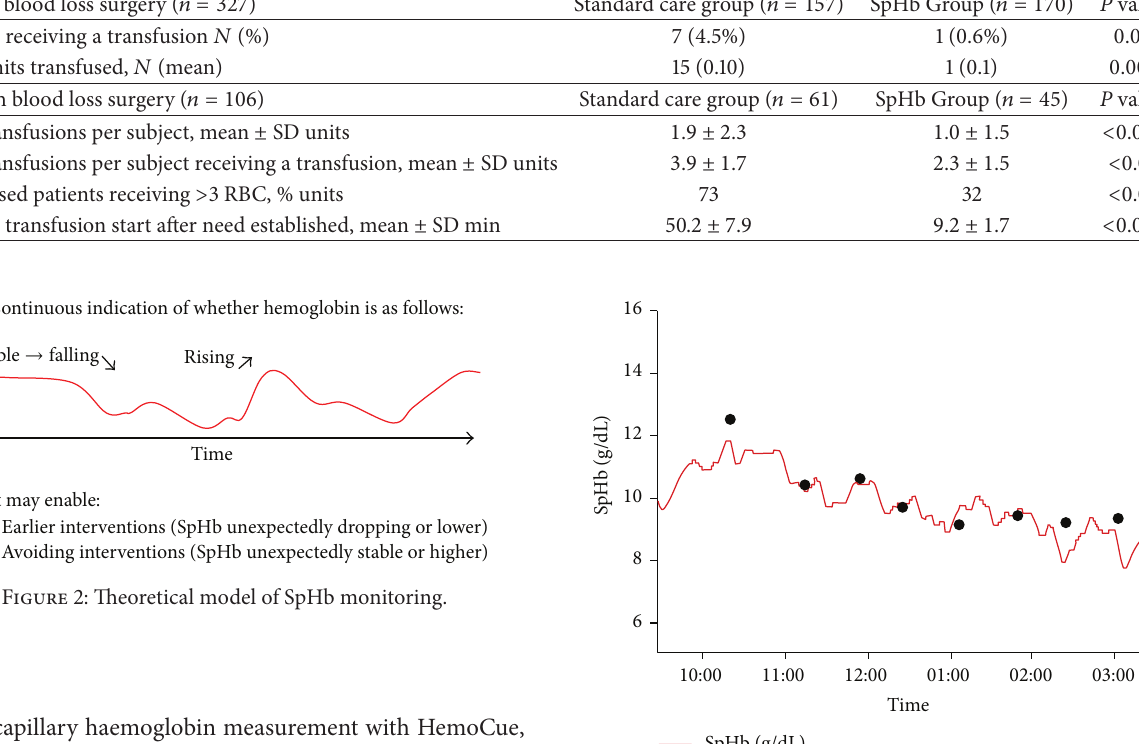
SpHb, capillary haemoglobin measurement with HemoCue,